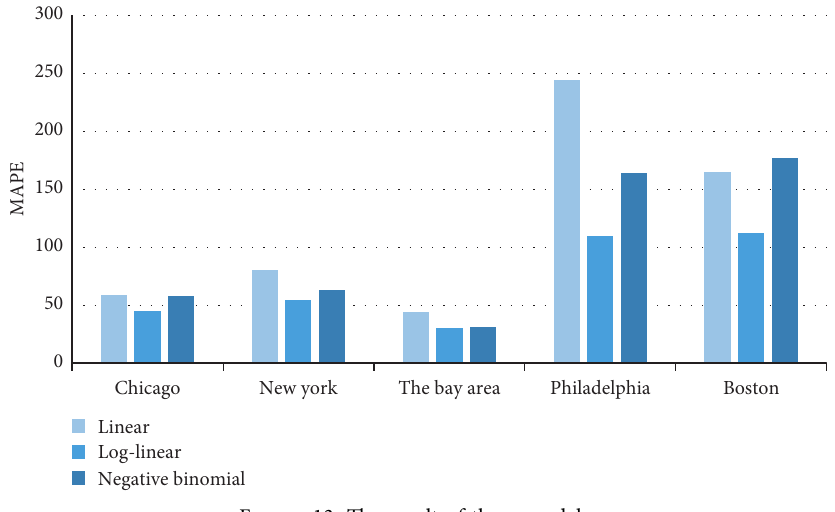
Figure 13: The result of three models. Table 5: Table of the adjusted R 2 of linear regression model in five cities.